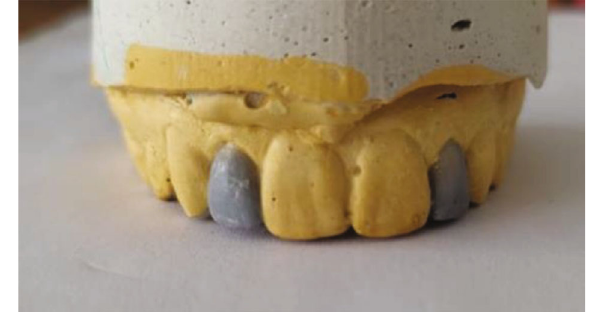
Figure 1: Initial situation showing peg-shaped lateral incisors.